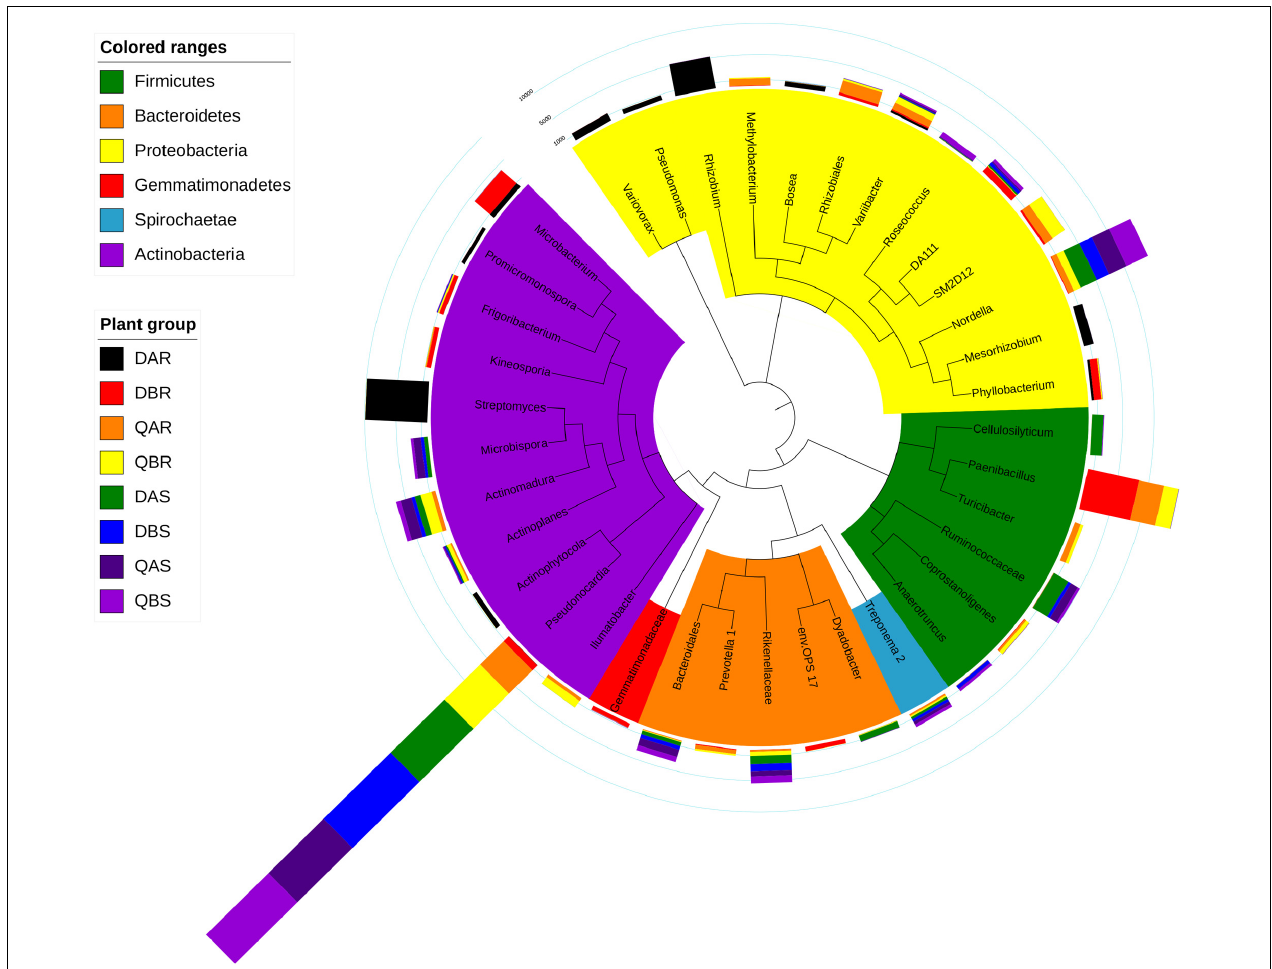
FIGURE 6 | Top operational taxonomic units (OTU) members of the bacterial microbiome. A taxonomic dendrogram showing the core bacterial microbiome of each plant group. Color ranges identify phyla within the tree. Colored bars represent the relative abundance of each OTU in each plant group. The taxonomic dendrogram was generated with one representative sequence of each OTU using FastTree and displayed using iTOL (Interactive Tree Of Life). The total relative abundances of all OTUs and the significant effects across plant compartments are listed in Supplementary Table S8